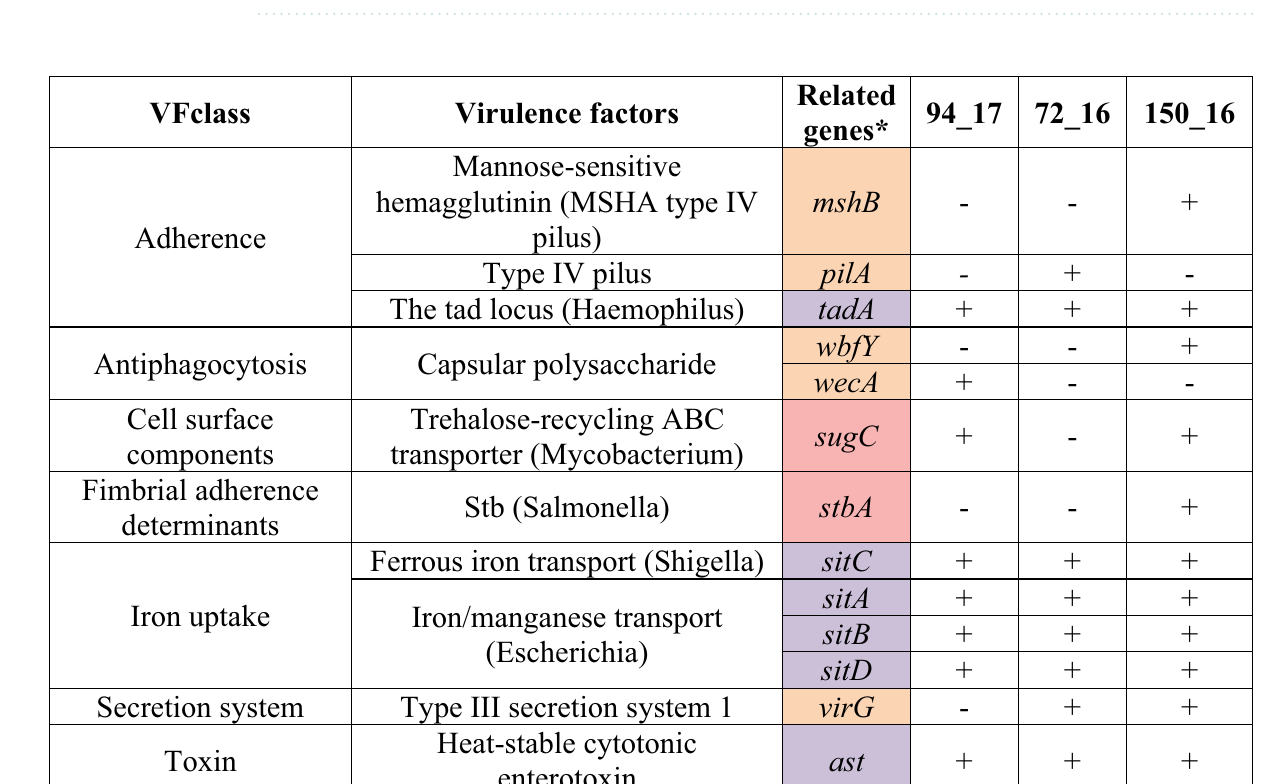
Table 4. Strict hits obtained by RGI analysis in CARD. ARO = antibiotic resistance ontology; AMR = Antimicrobial resistance.